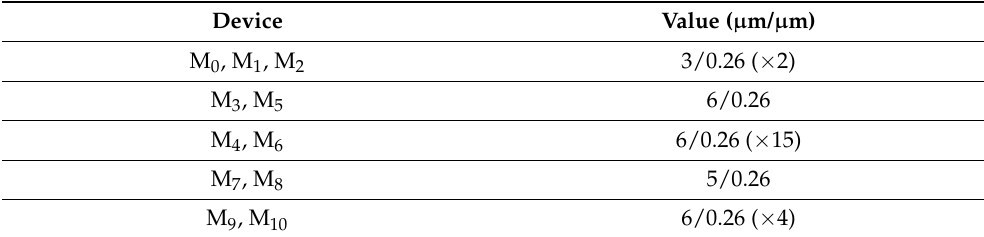
Table 1. Transistor